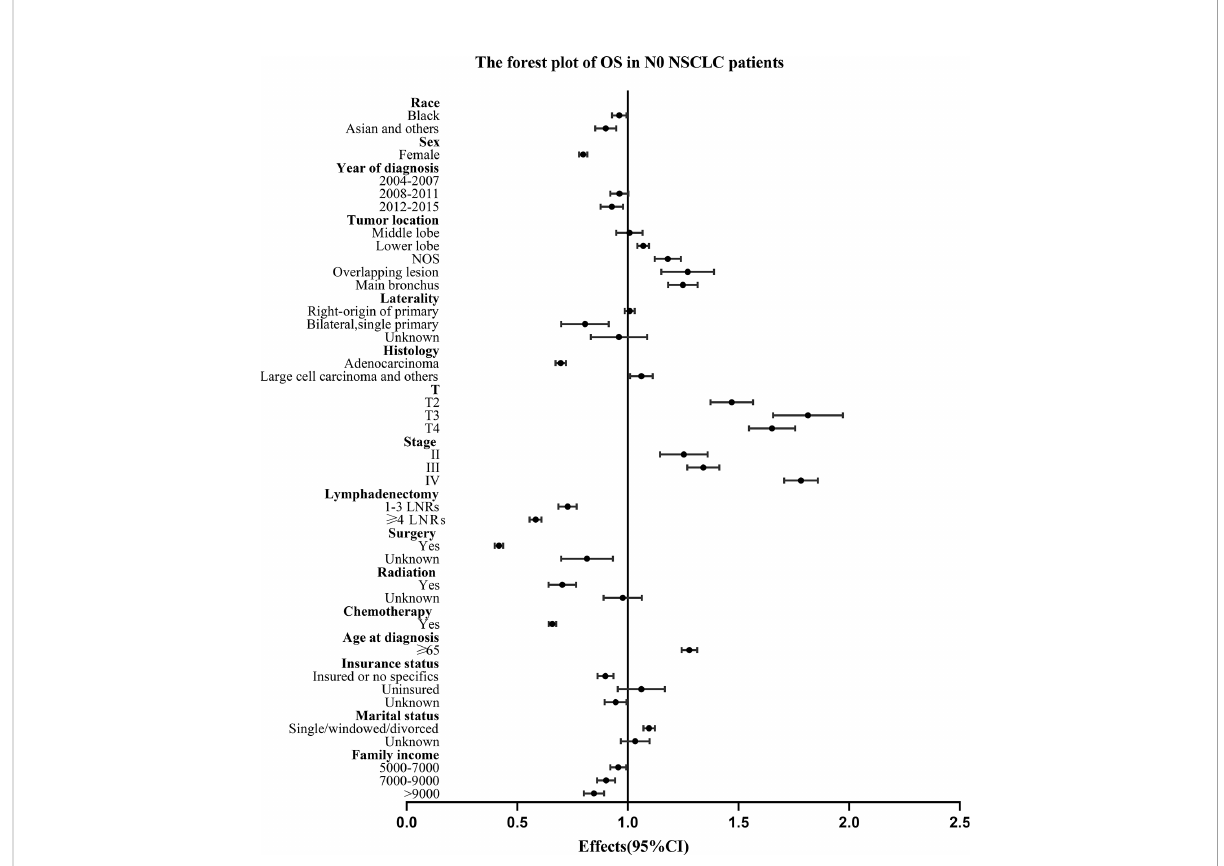
FIGURE 4 Forest plot of variables that can in fl uence OS in N0 NSCLC patients. NSCLC, non-small cell lung cancer; CI, con fi dence interval; OS, overall survival; LNRs, lymph nodes